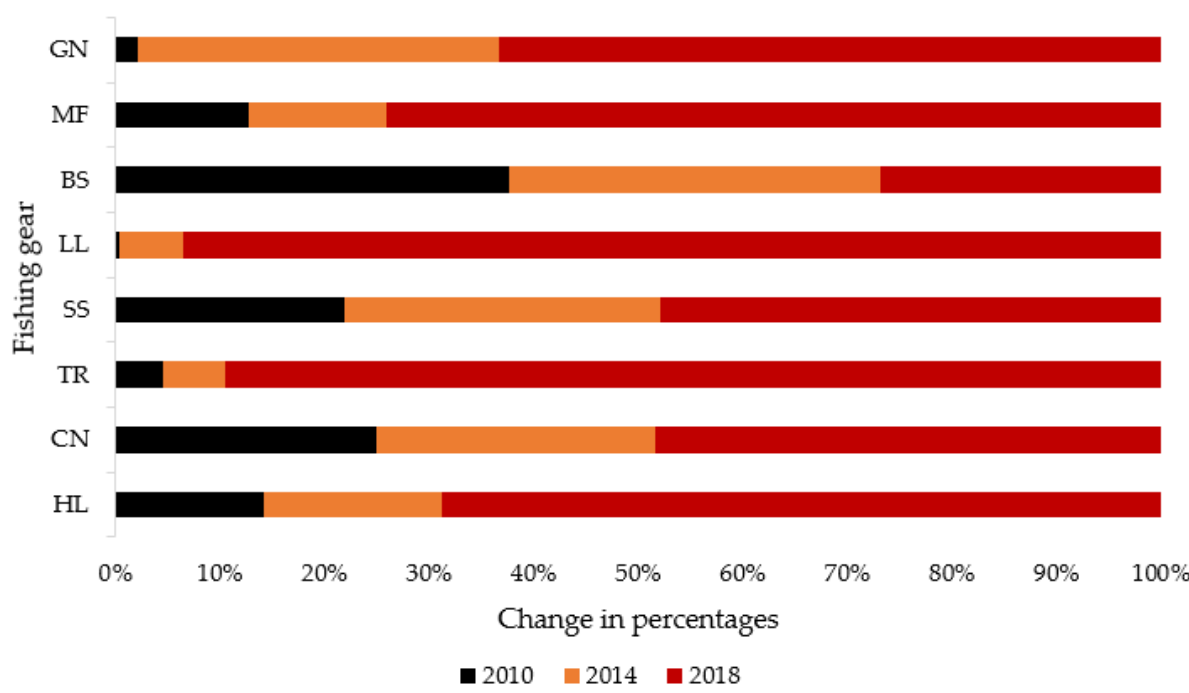
Figure 8. Fishing gear used on Lake Kyoga for the years 2010, 2014 and 2018 and their percentage change (source: NaFIRRI/DiFR). Table 4. Number of fishing gear used on Lake Kyoga in 2010, 2014 and 2018 (source: NaFIRRI/DiFR). Fishing